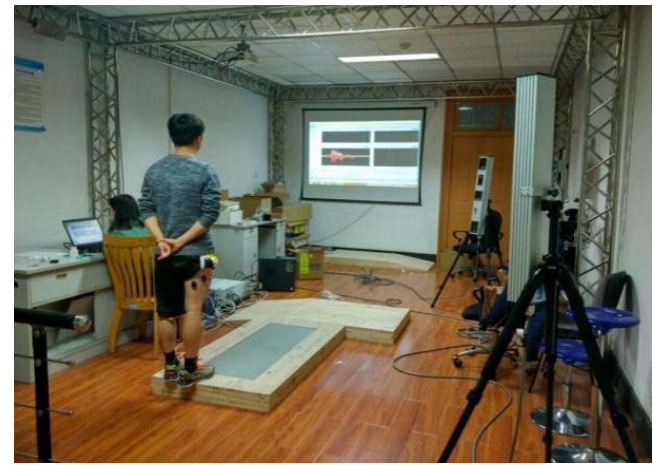
Figure 5. Experimental platform.